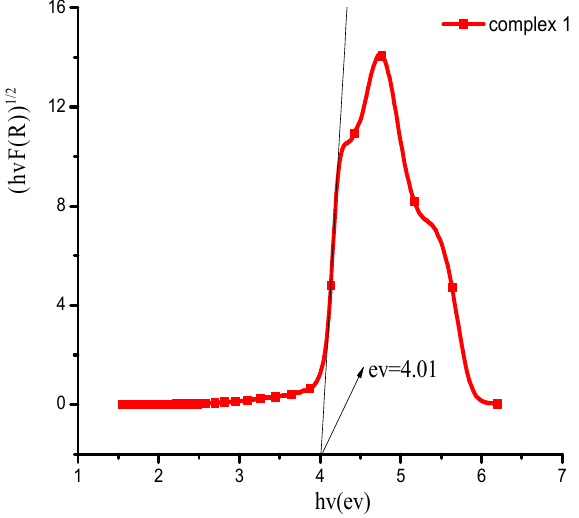
Figure 6. The band gap with 4.01 ev by the treatment with the Kubelka–Munk function.